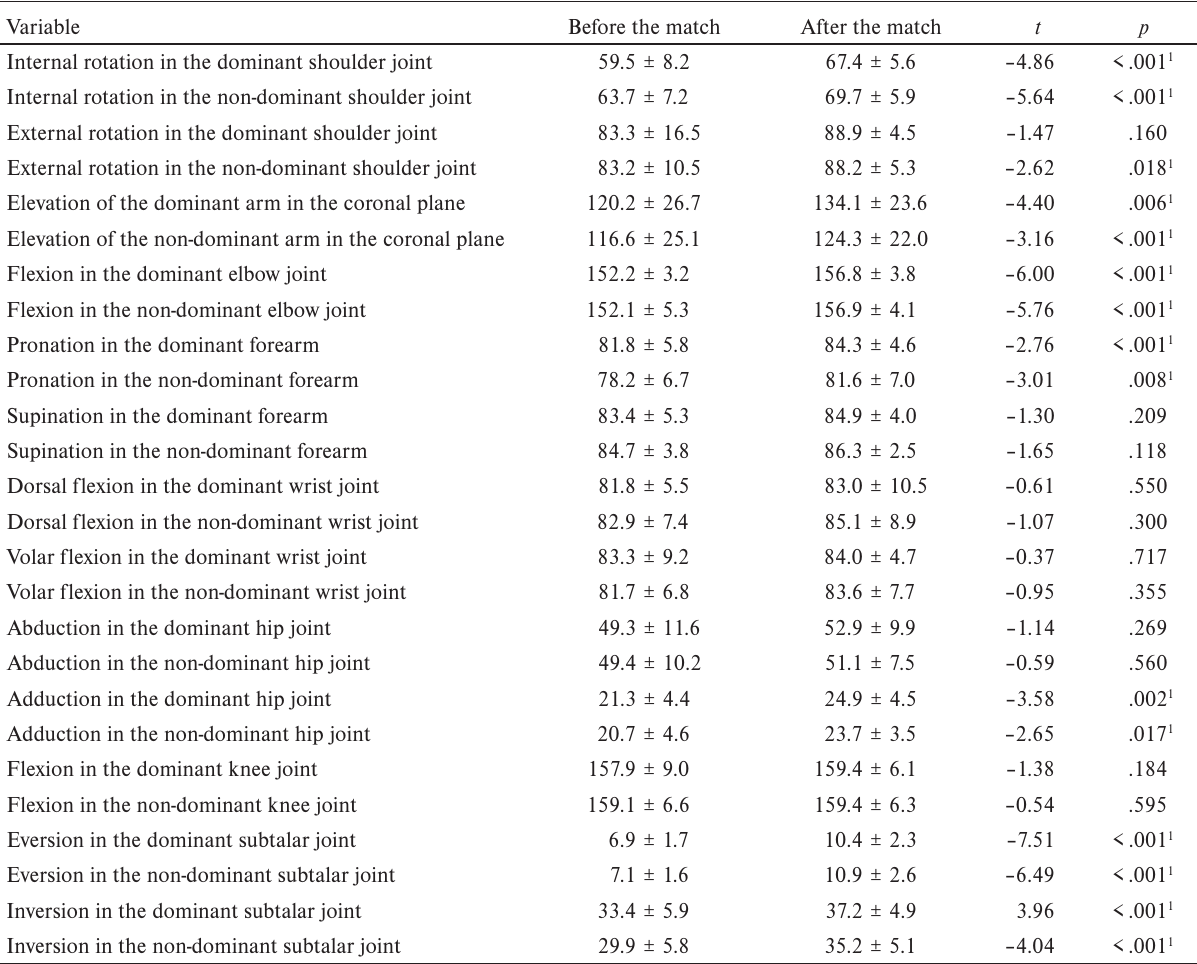
Table 3 Range of motion before and after the match in the dominant and non-dominant shoulder, elbow, wrist, hip, knee, and ankle. Values are presented in degrees as mean ±